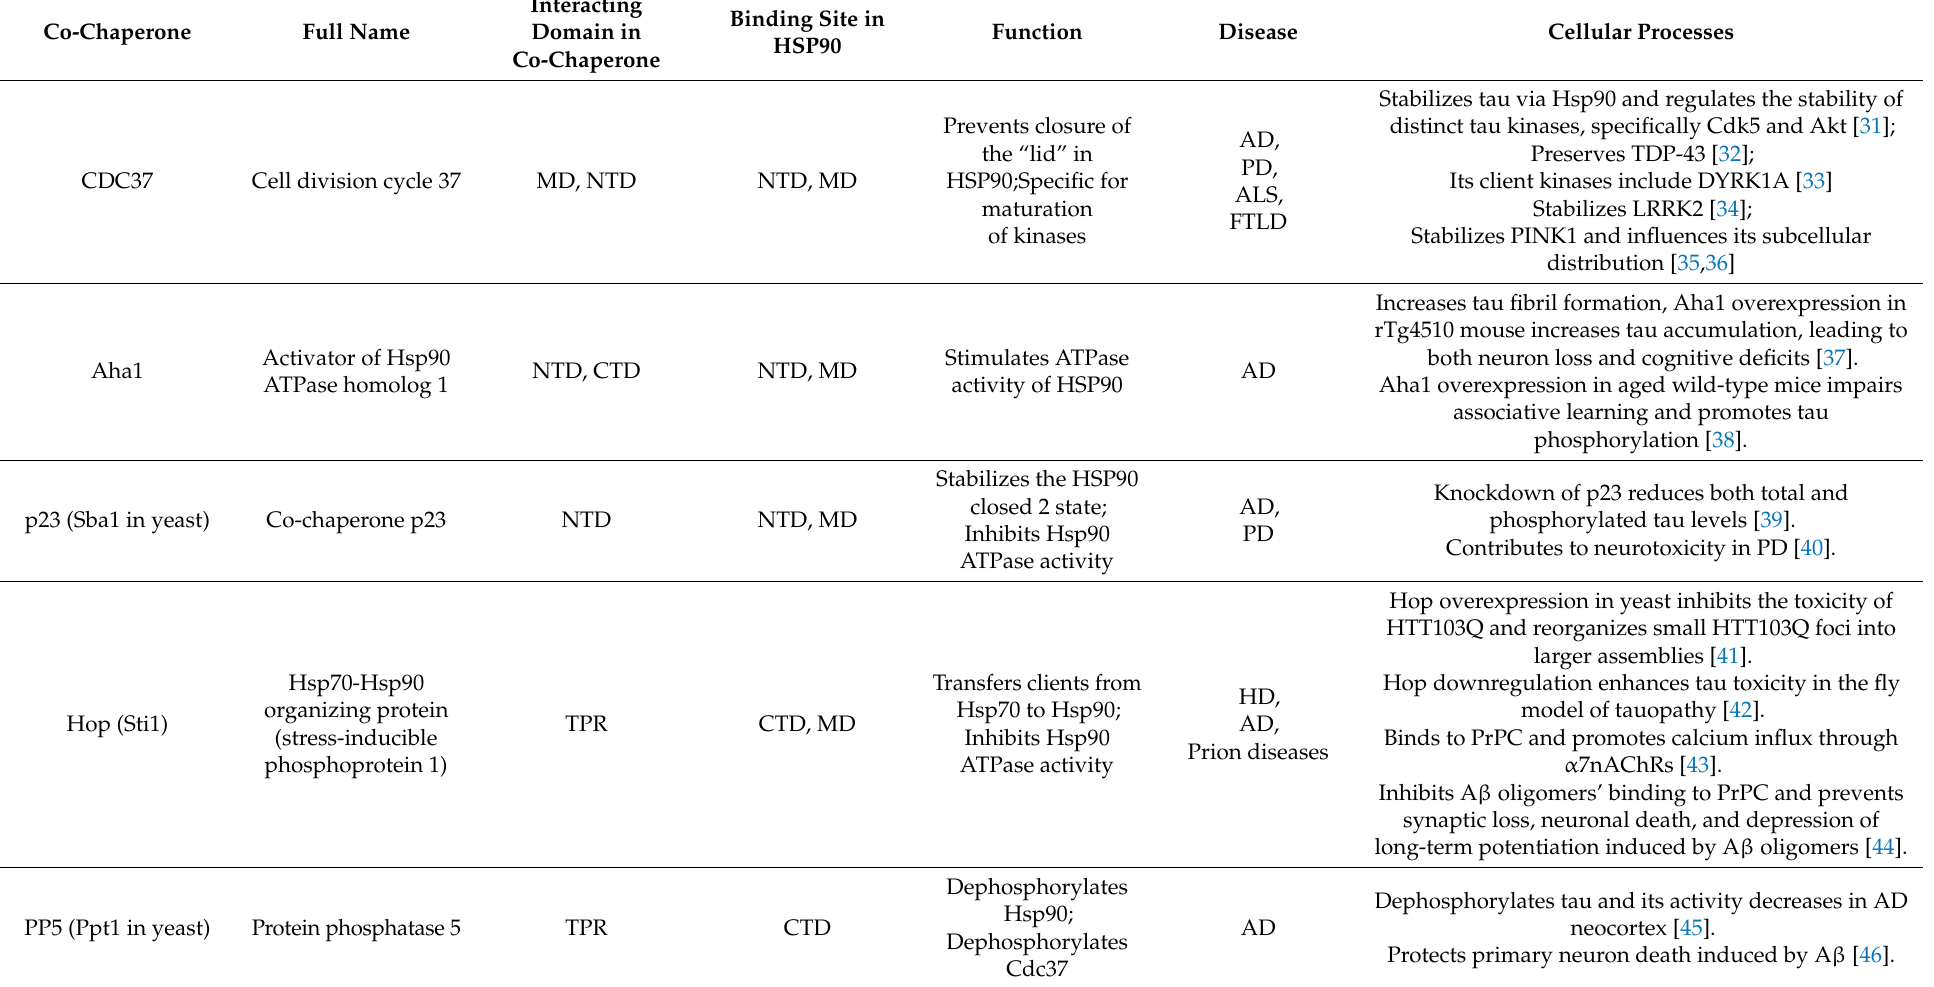
Table 1. Hsp90 co-chaperones, their regulation of Hsp90 function, and involvement in processes related to